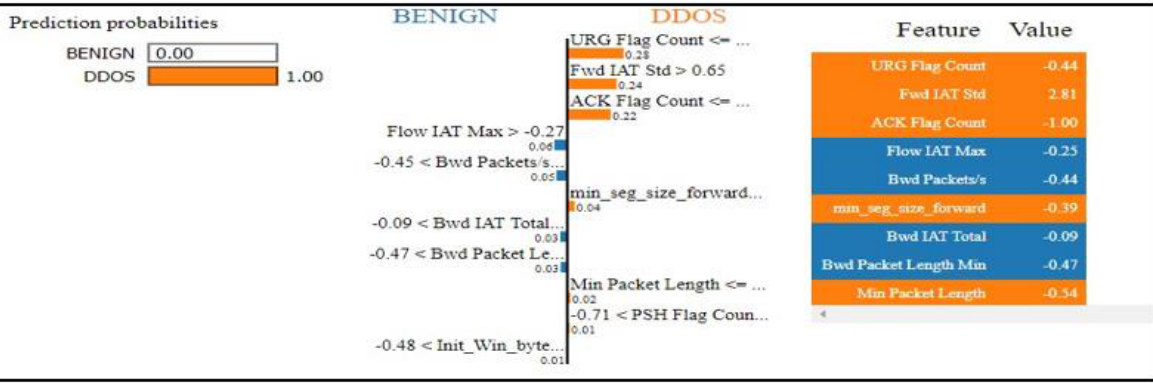
Figure 15. LIME observations for decision tree.